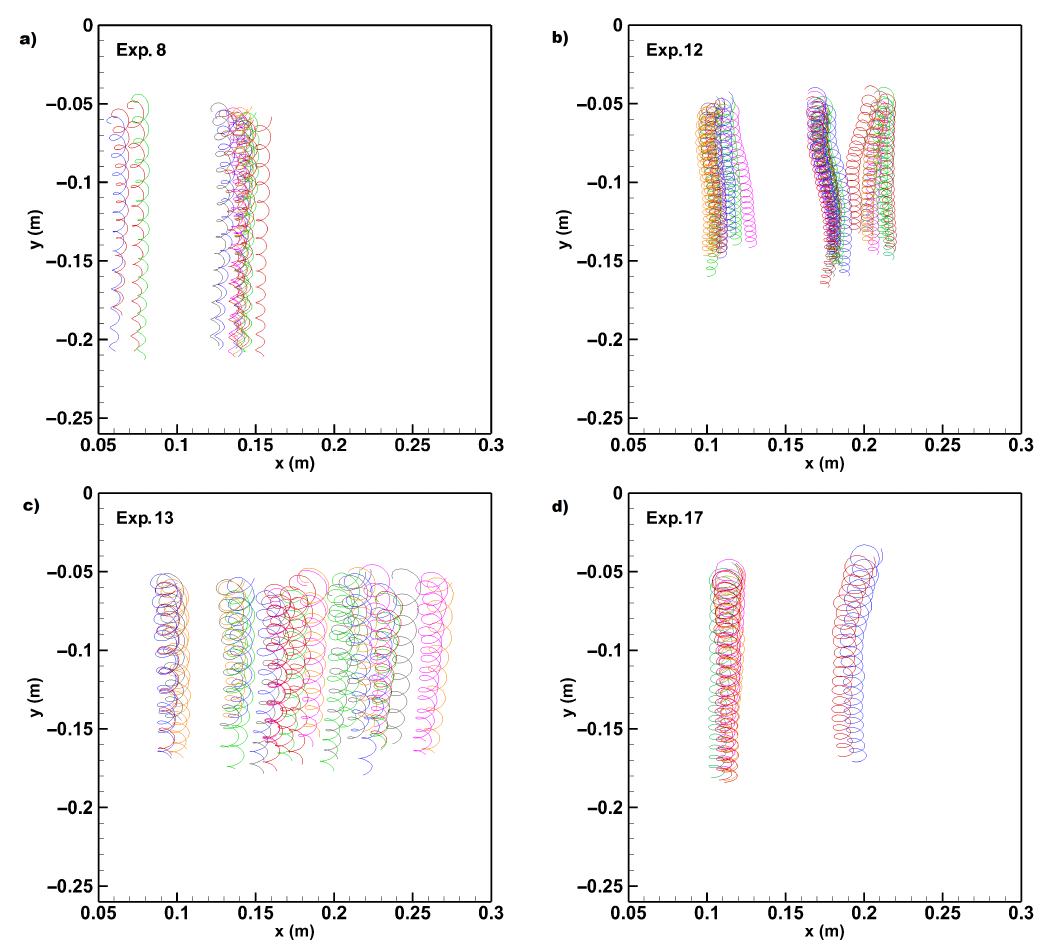
Figure 3. Examples of measured trajectories for Experiments ( a ) 8, ( b ) 12, ( c ) 13, and ( d )